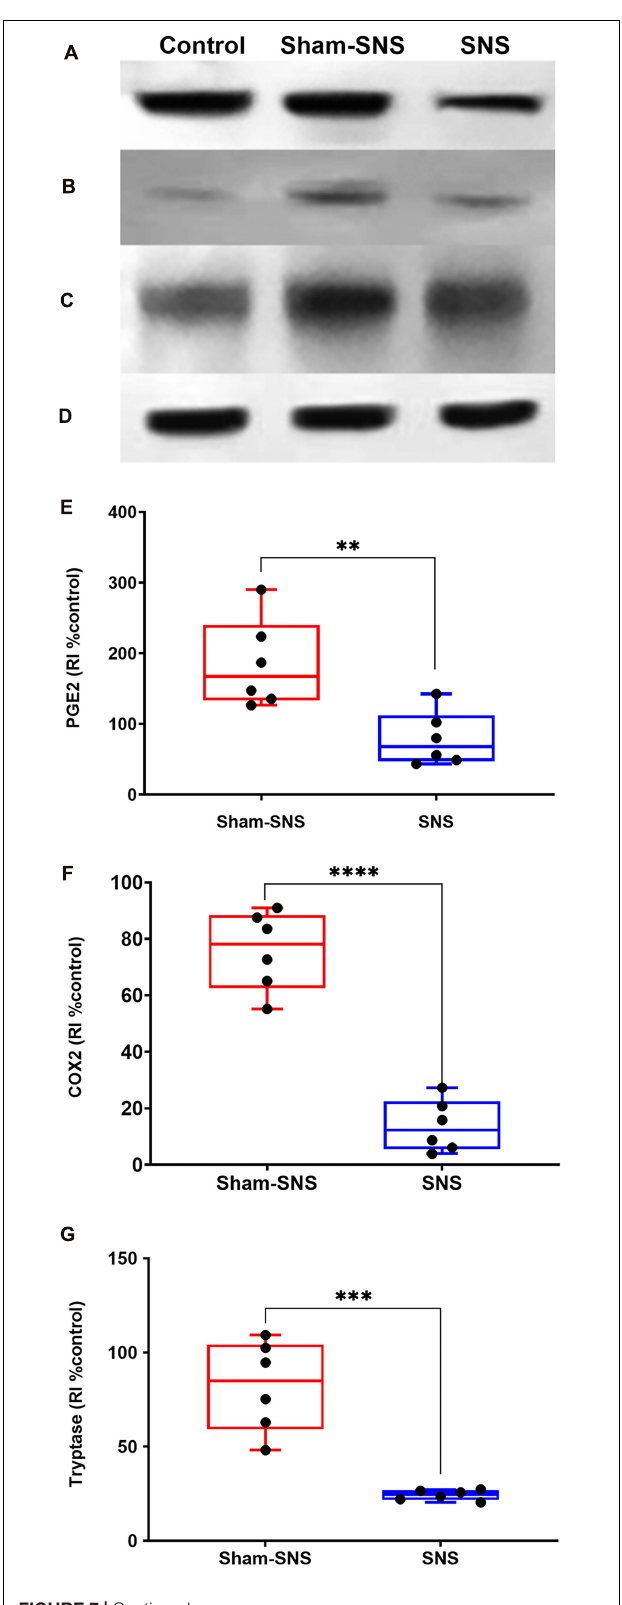
FIGURE 6 | Effects of chronic SNS and sham-SNS on protein expression of ChAT (A,E) , nNOS (B,F) , PGP9.5 (C,G) , and GAPDH (D) in middle third of colon of visceral hypersensitive rats in comparison with the control (normal rats). (A) Illustrates ChAT immunoblot (72 kDa), while panel (E) displays the percent change of protein expression of ChAT in colon tissue compared to control group. SNS markedly upregulated ChAT protein expression in colon tissue after 3 weeks treatment. Panel (B) shows nNOS immunoblot (170 kDa), while panel (F) represents the percent change of protein expression of nNOS in colon tissue compared to control group. nNOS that was upregulated in sham-SNS group was downregulated after a 3-week SNS. Panel (C) show PGP9.5 immunoblot (25 kDa), while panel (G) illustrates the percent change of protein expression of PGP9.5 in colon tissue compared to control group. PGP9.5 protein expression did not alter by 3-week SNS. Values were represented as the means ± SE ( n = 6) as percentage of relative intensity normalized to internal control (GAPDH, 36 kDa). SNS, sacral nerve stimulation, RI, relative intensity ** p < 0.01; Student hbox t